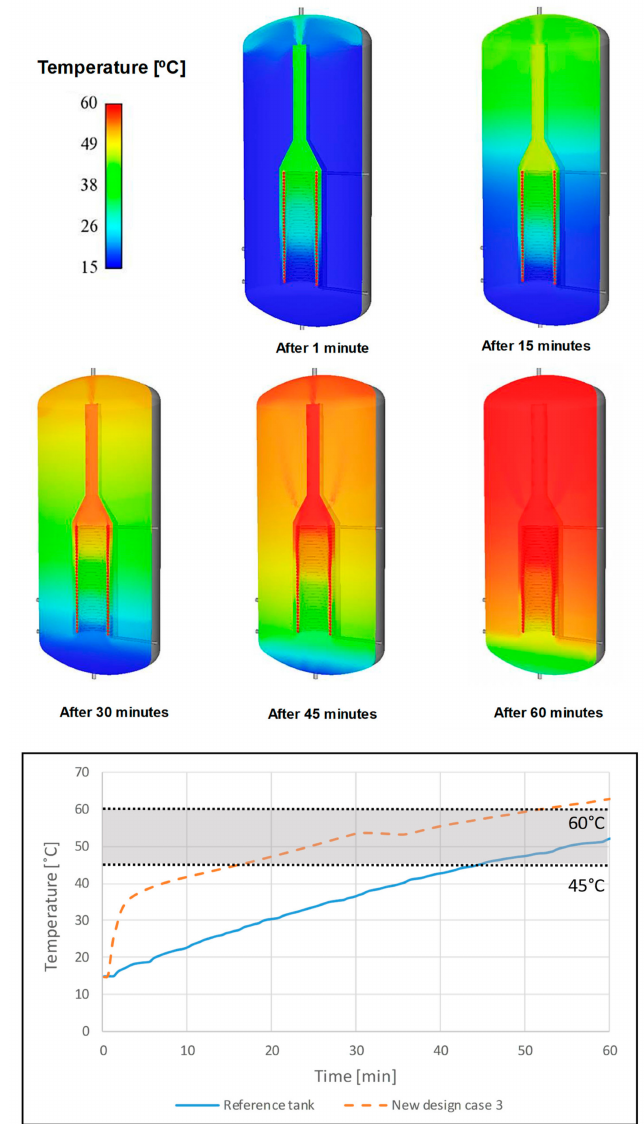
Figure 9. Evolution of the temperature field in simulation 3 and comparison of DHW temperatures with the reference case (average temperature at the DHW